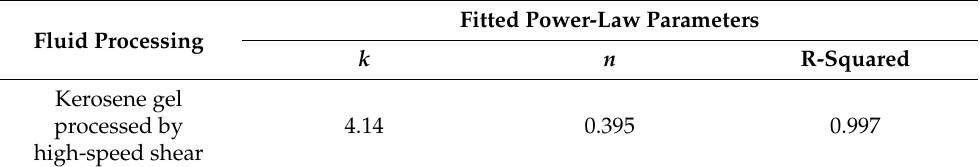
Table A3. Power-law model parameters of the gels after high-speed shearing.